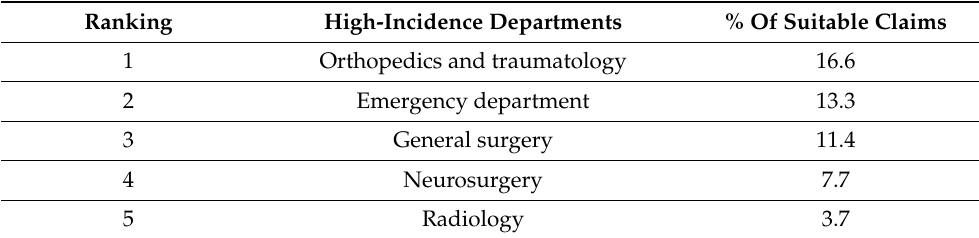
Table 1. High-incidence wards or services (general